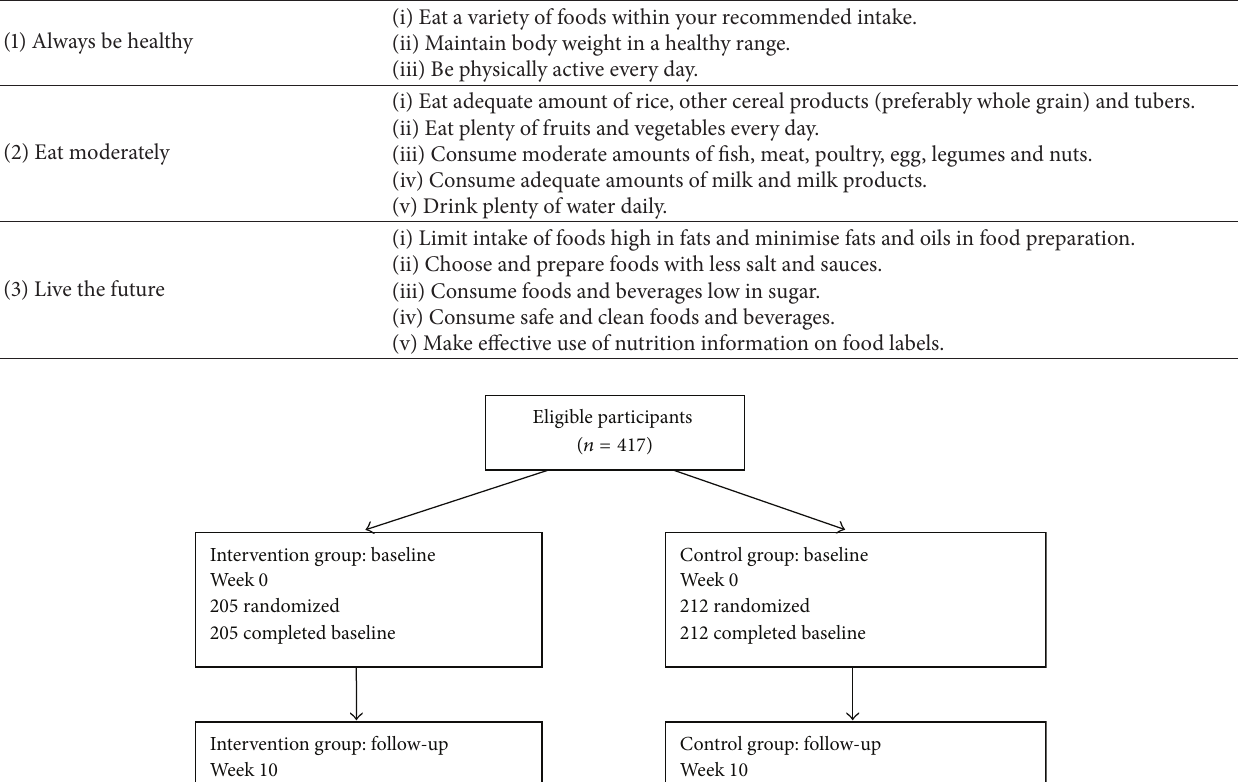
Table 1: The themes and key messages incorporated in the nutrition education module [21]. Themes